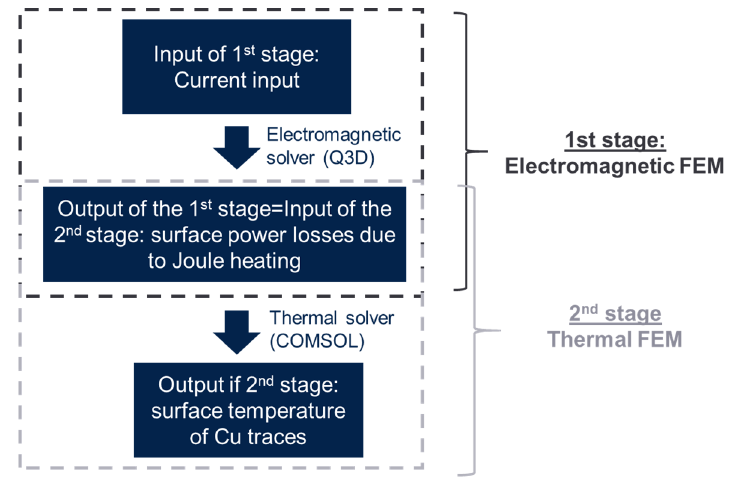
Figure 3. Workflow of the proposed